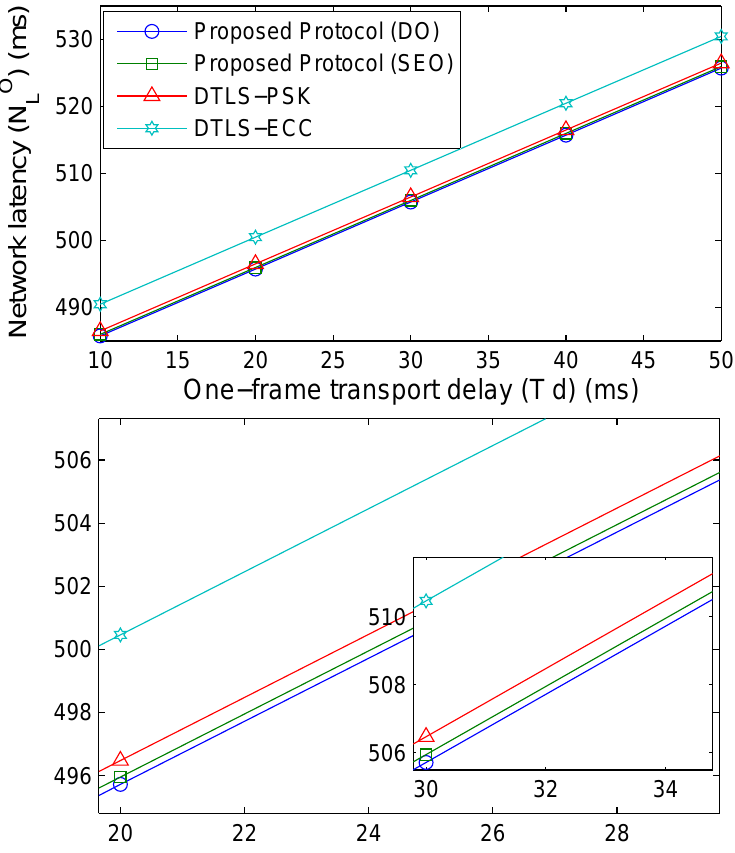
Figure 18. Network latency (ms) vs. transport